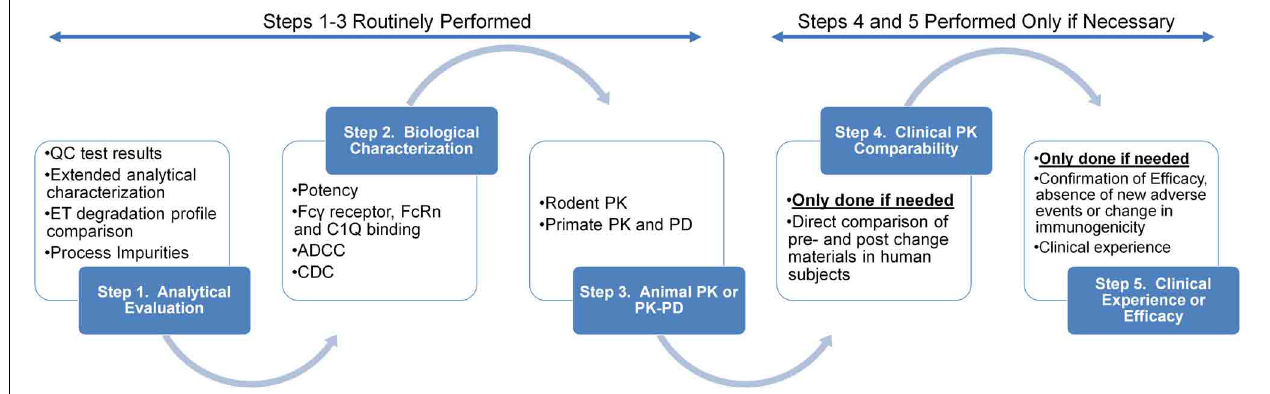
the susceptibility of an IgG to papain digestion (Raju and Scallon, 2006,